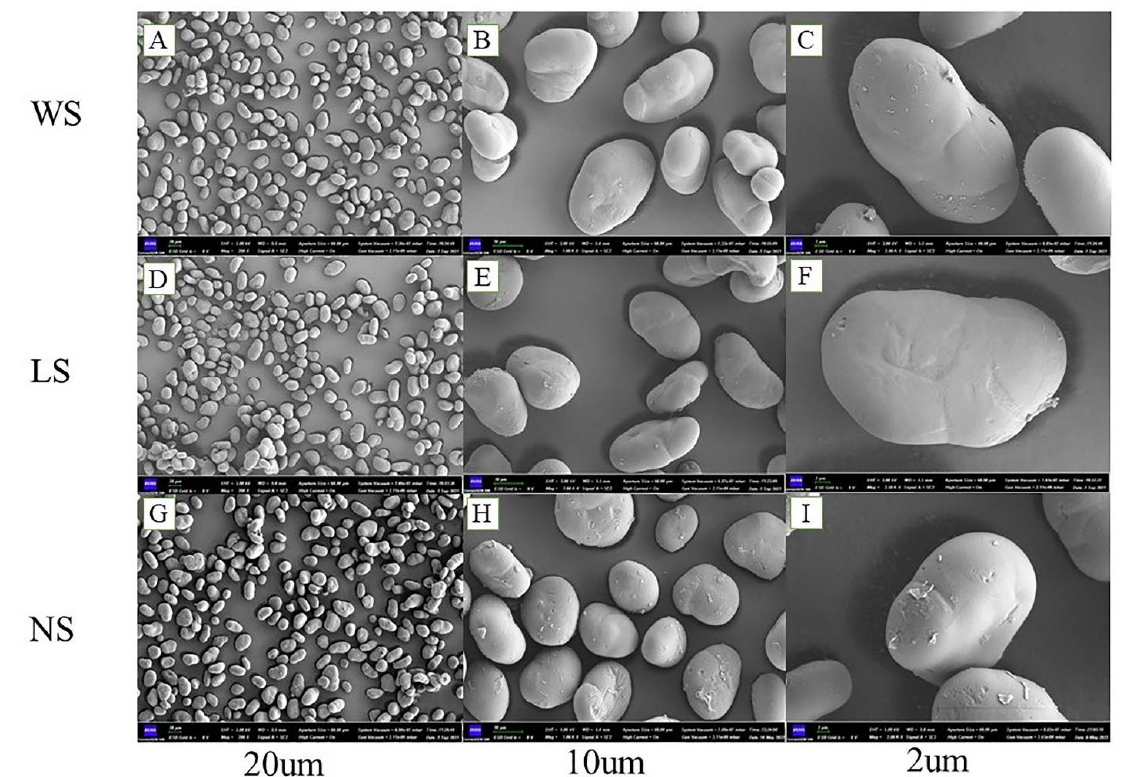
Figure 1. Scanning electron micrographs of starch samples extracted by different methods. Figures ( A – C ) are images of WS starch magnified at 200×, 1000×, and 2000×, respectively. Figures ( D – F ) are images of LS starch magnified at 200×, 1000×, and 2000×, respectively. Figures ( G – I ) are images of NS starch magnified at 200×, 1000×, and 2000×, respectively. Table 2. Particle size distribution, molecular weight, and the chain length distribution of starch sam- ples extracted by different methods.